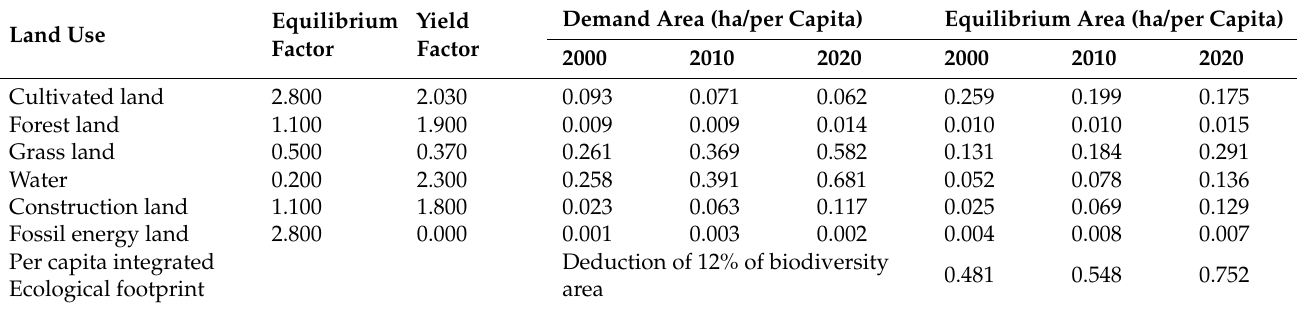
Table 2. Per capita ecological footprint calculation of Nanchang